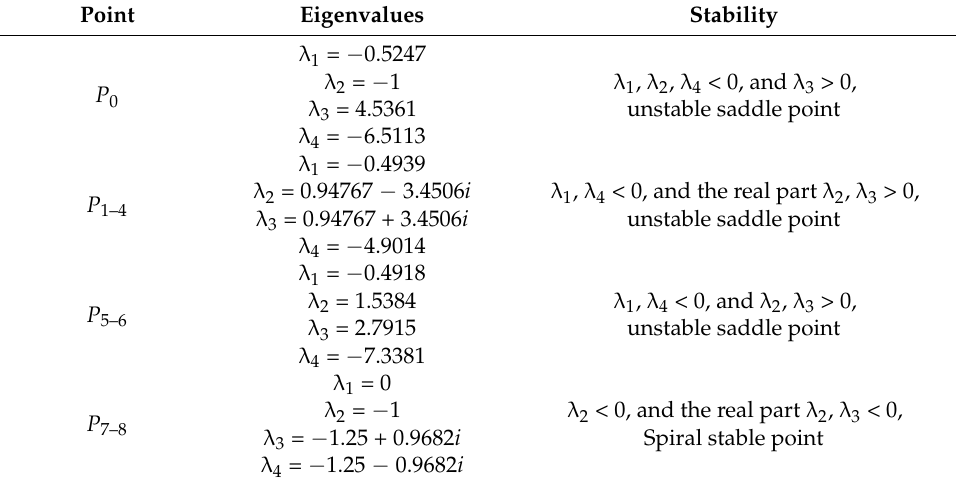
Table 1. Stability analysis equilibrium points for new hyperchaotic system (NHS). Point Eigenvalues